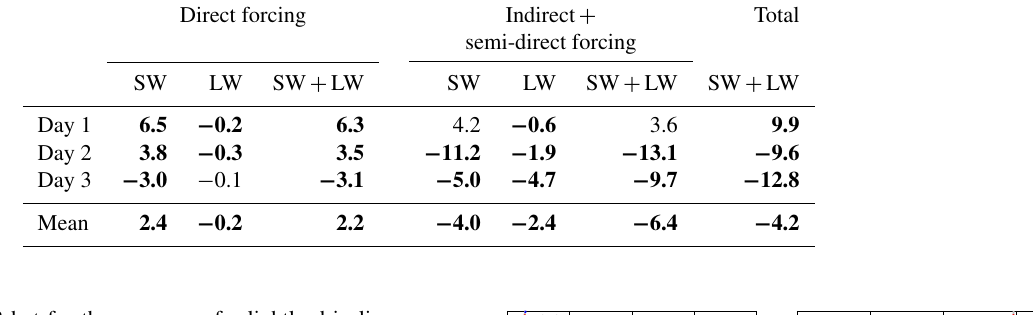
Table 8. As in Table 2 but for the response of a lightly drizzling baseline to a perturbation of moisture instead of aerosol. Boldface indicates results exceeding the uncertainty range derived from the spread of the lightly drizzling baseline ensemble.